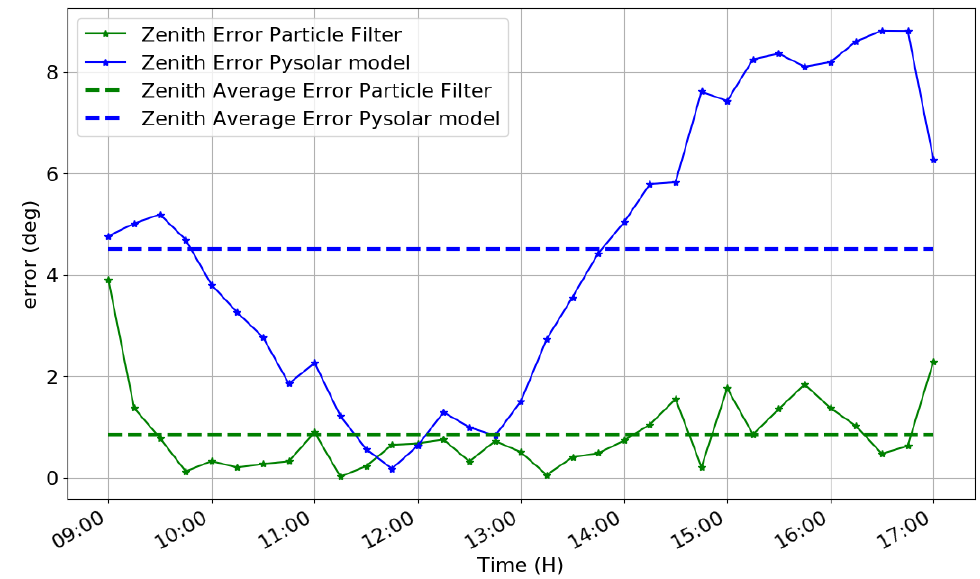
Figure 26. Solar zenith error.